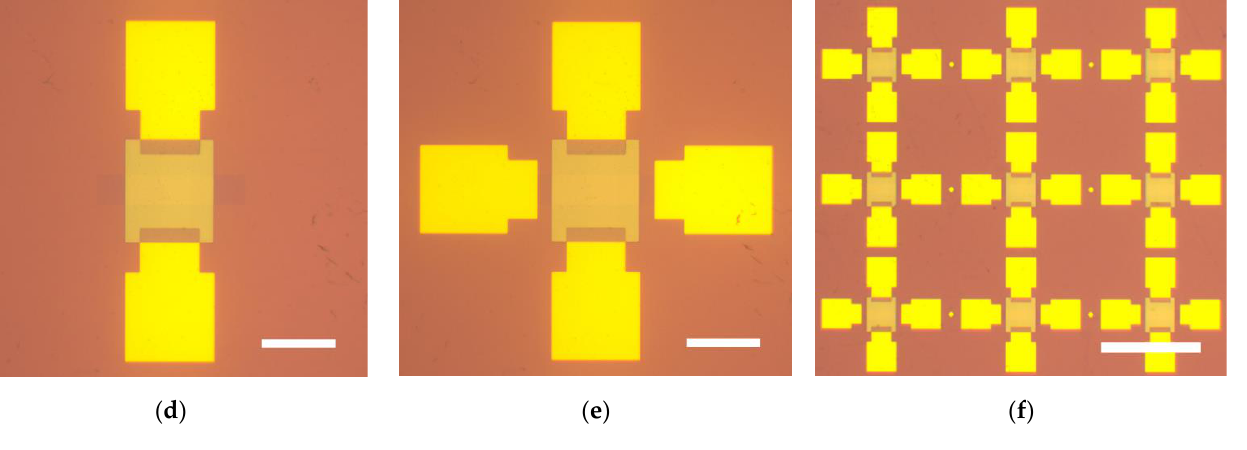
Figure 2. The optical images taken after each main fabrication step: ( a ) the striped bottom graphene; ( b ) the graphene with Pd/Au electrodes fabricated on two ends of it for measurement purposes; ( c ) the optical image taken after the MoTe 2 film was transferred and patterned onto the bottom graphene. Herein, the rectangular MoTe 2 was designed to completely cover the exposed bottom graphene in order to prevent it from the subsequent etching and the short circuit with the top graphene; ( d ) another graphene film was transferred onto the top of the MoTe 2 and etched into striped shape that was perpendicular to the bottom graphene; ( e ) finally, the Pd/Au electrodes contacting the top graphene were fabricated. In the vertical heterostructure, the bottom and top graphene layers act as electrodes, and the MoTe 2 sheet in between serves as light absorption layer; ( f ) the graphene – MoTe 2 – graphene vertical vdWs heterostructure array, which demonstrates the feasibility of our large-scale fabrication method. The scale bar in ( a – e ) is 100 µm. The scale bar in ( f ) is 400 µm.